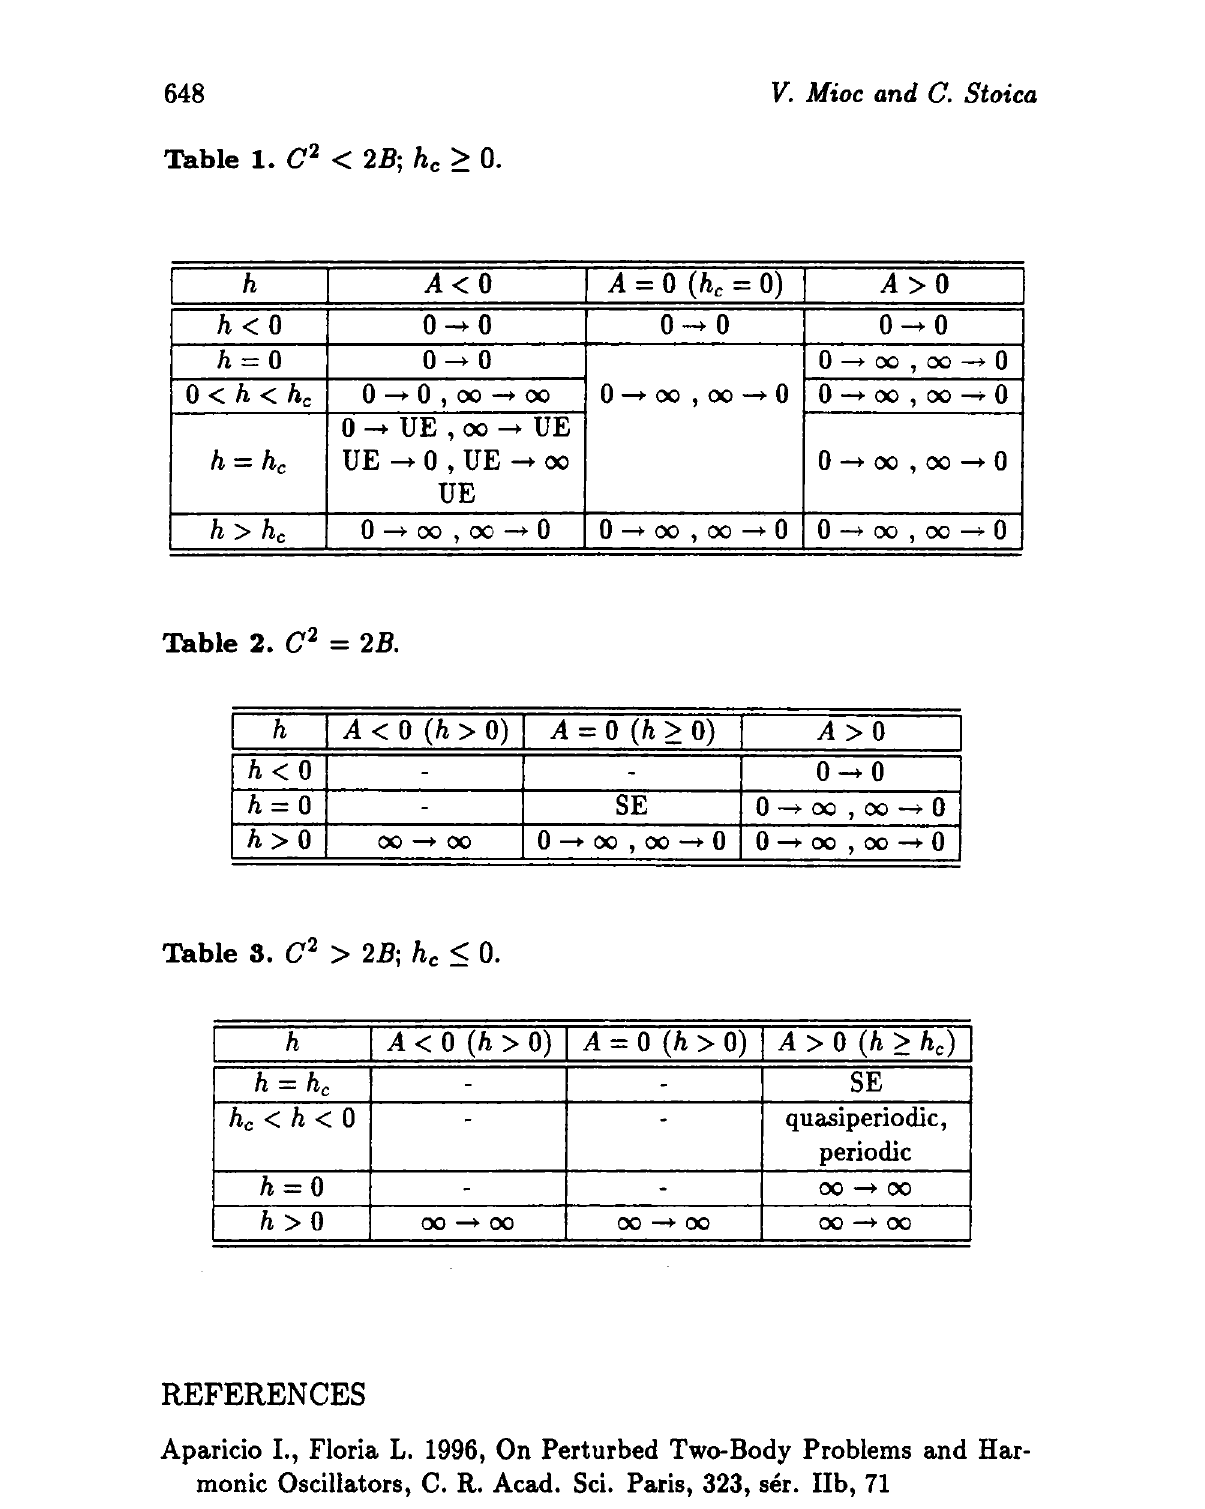
Table 1. C 2 < 25; h